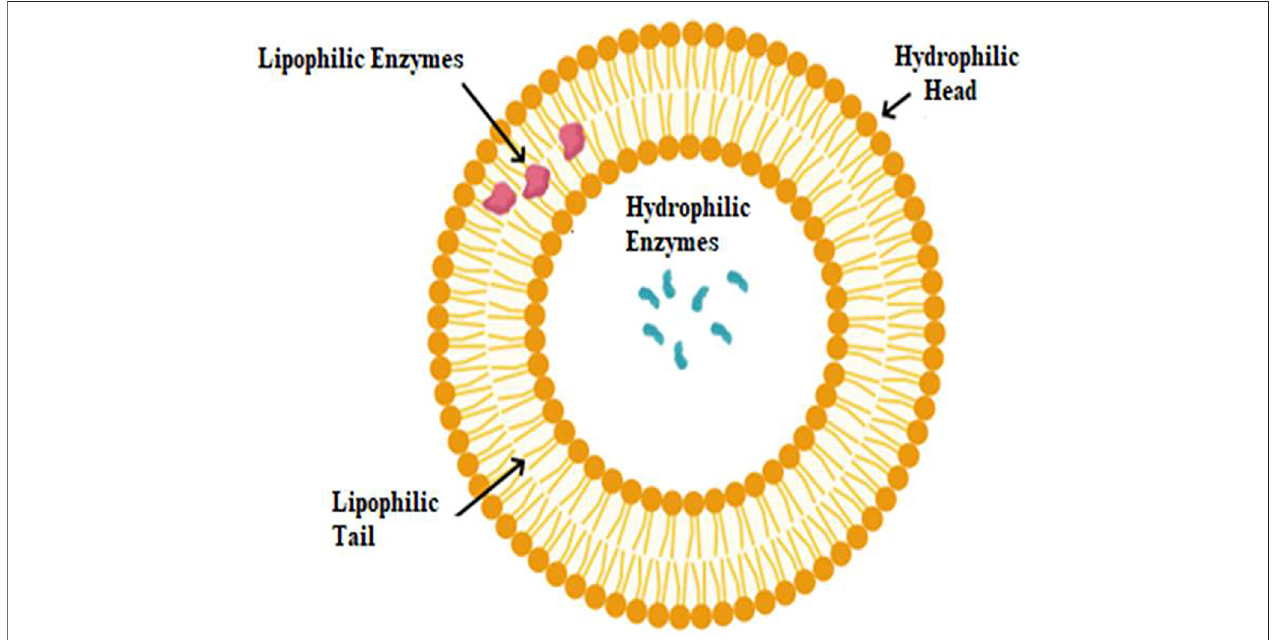
FIGURE 2 | Schematic description of hydrophilic and lipophilic enzyme localization on liposomes.